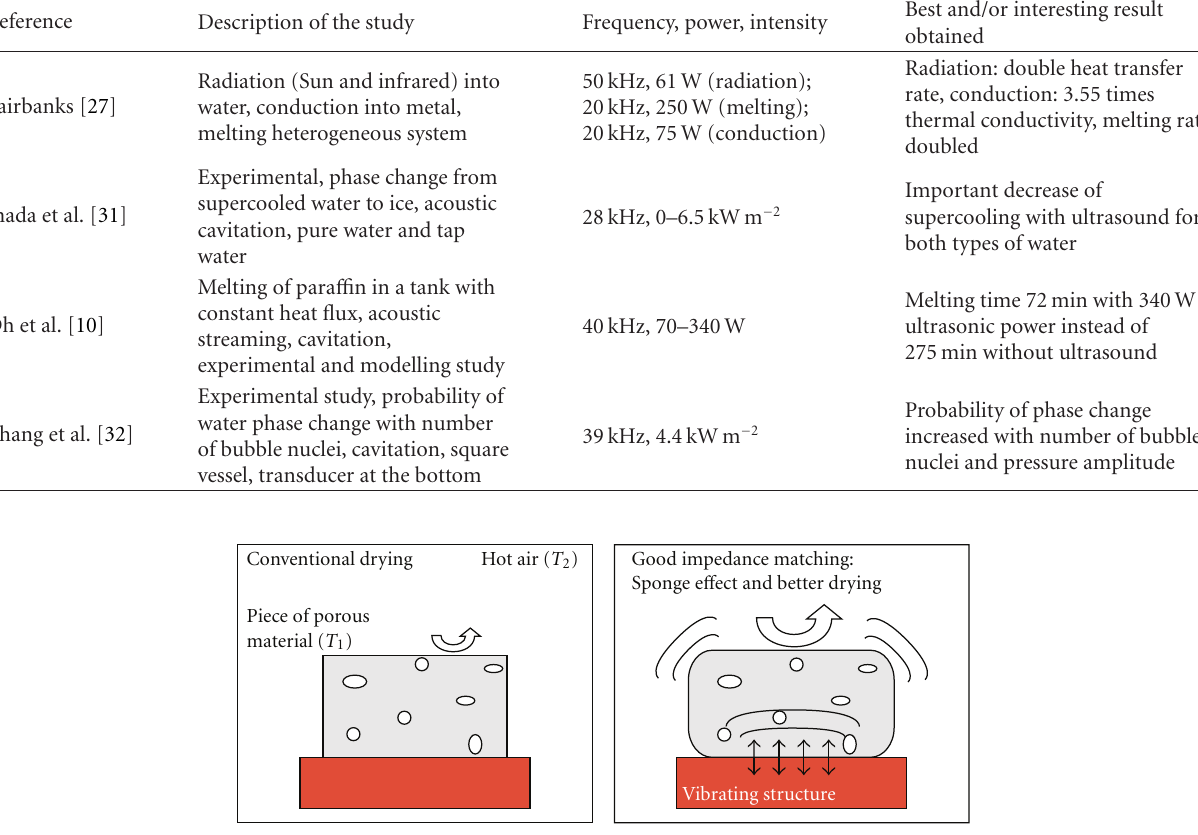
Table 1: Various uses of ultrasound to promote phase change heat transfer.